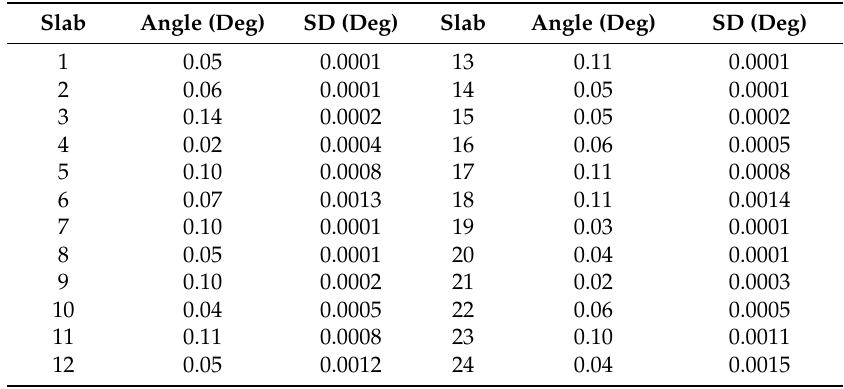
Table 3. Values of the angle ϑ between the local orthogonal lines and the perpendicular to the general plane together with the associated